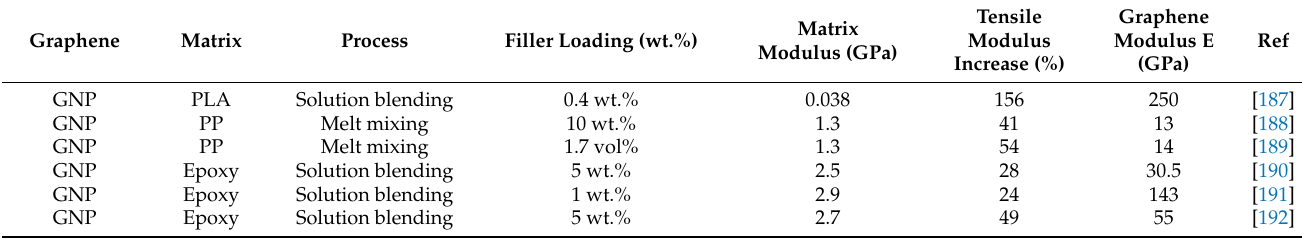
Table 1. Mechanical properties of graphene polymer